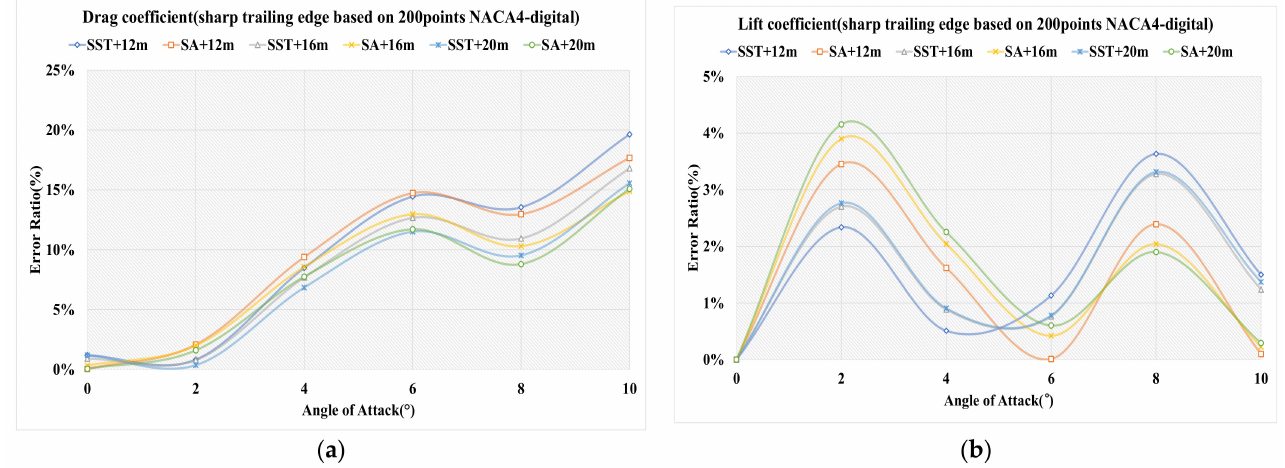
Figure 7. ( a ) Drag coefficient of sharp trailing edge based on NACA 4-digital; ( b ) lift coefficient of sharp trailing edge based on NACA 4-digital.